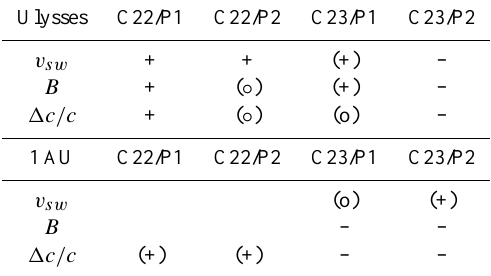
Table 2. Periodicities in the solar wind velocity ( v sw ) and magnetic field ( B ) as well as for the detrended cosmic ray flux ( 1c/c ) for the different time intervals as measured by Ulysses (upper half) and by various spacecraft (cf. text) at 1AU in the ecliptic plane (lower half). Plus and minus signs refer to a peak clearly above and below the line of significance in the Lomb analysis, respectively. Peaks close to this line are shown by an open circle. The brackets indicate a periodicity with a slightly ( > ∼ 1 day) deviating periodicity.